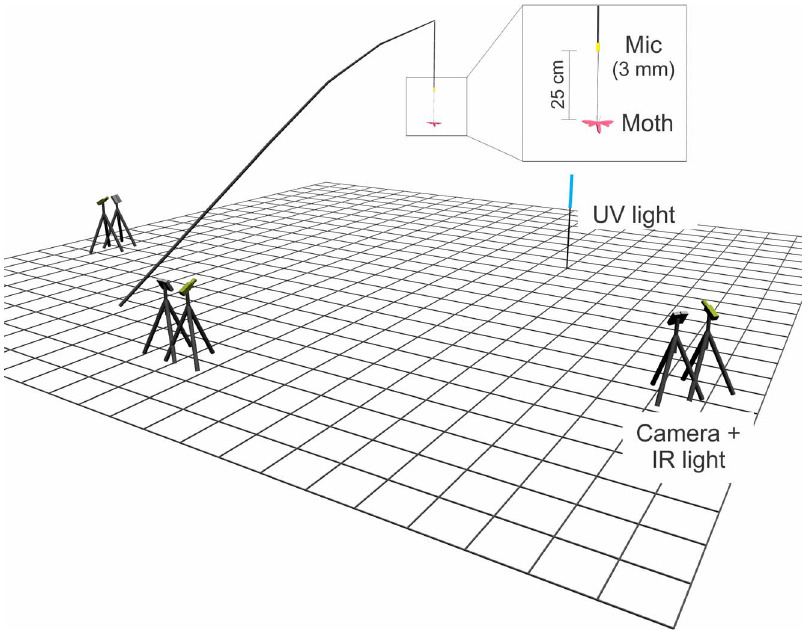
Figure 3. Three-dimensional schematic of field setup for recording bat attacks on tethered and free-flying moths. Three infrared cameras recorded bat flight trajectories, positions of tethered and free-flying moths, and positions and directional axes of the ultrasound microphone. An ultraviolet light attracted free-flying moths and foraging bats to the observation area. In field experiment 1 a silent noctuid moth was tethered and suspended along with a miniature (3 mm diameter) microphone from a 10 m telescoping pole. The microphone’s close proximity to the tethered moth allowed for estimating bat call intensities emitted in the moth’s direction (10 cm from the bat’s mouth) and arriving at the moth for attacks on the tethered moth (real attacks) and attacks on nearby free-flying moths (false threats). In field experiment 2, the clicking moth Bertholdia trigona was tethered below the microphone and bat passes that elicited a clicking response were compared to passes that did not elicit clicking.